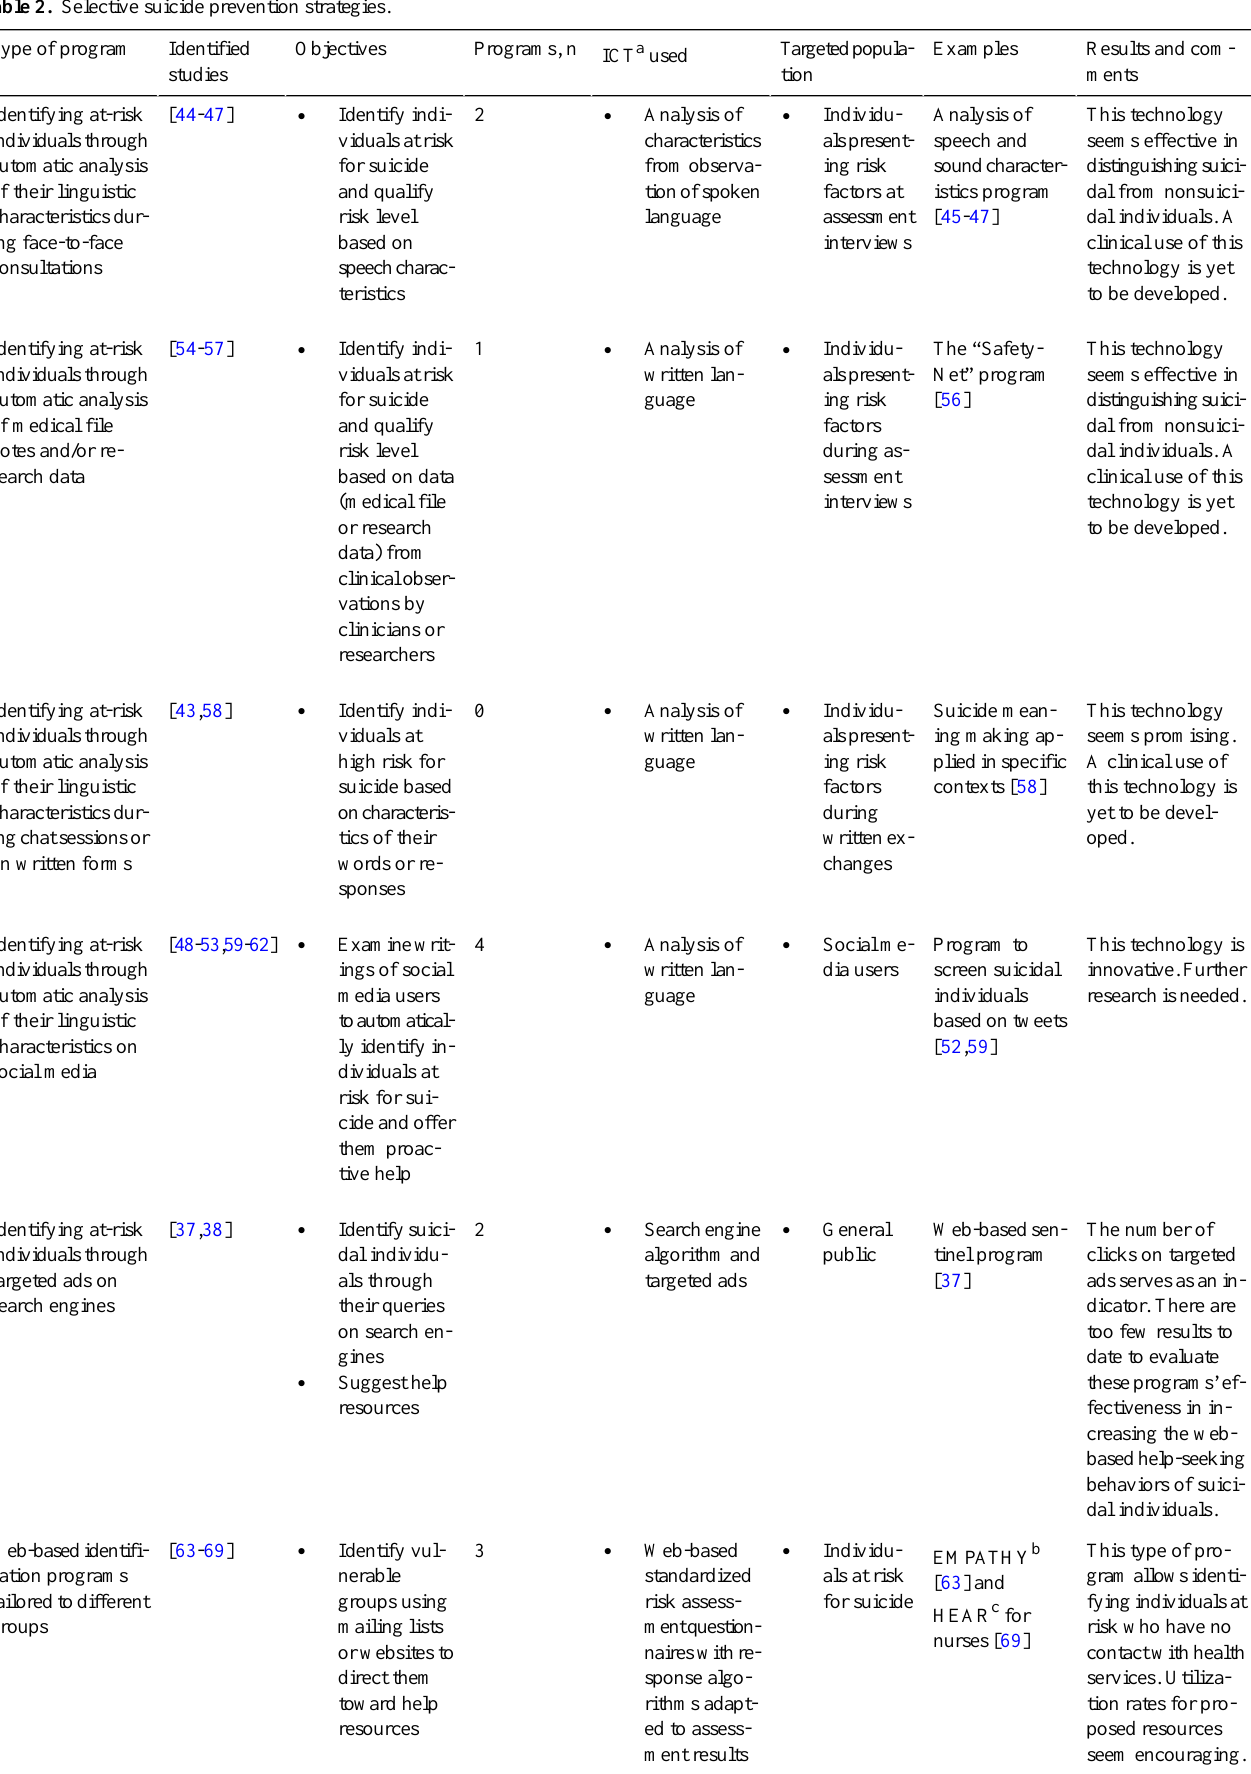
Table 2. Selective suicide prevention